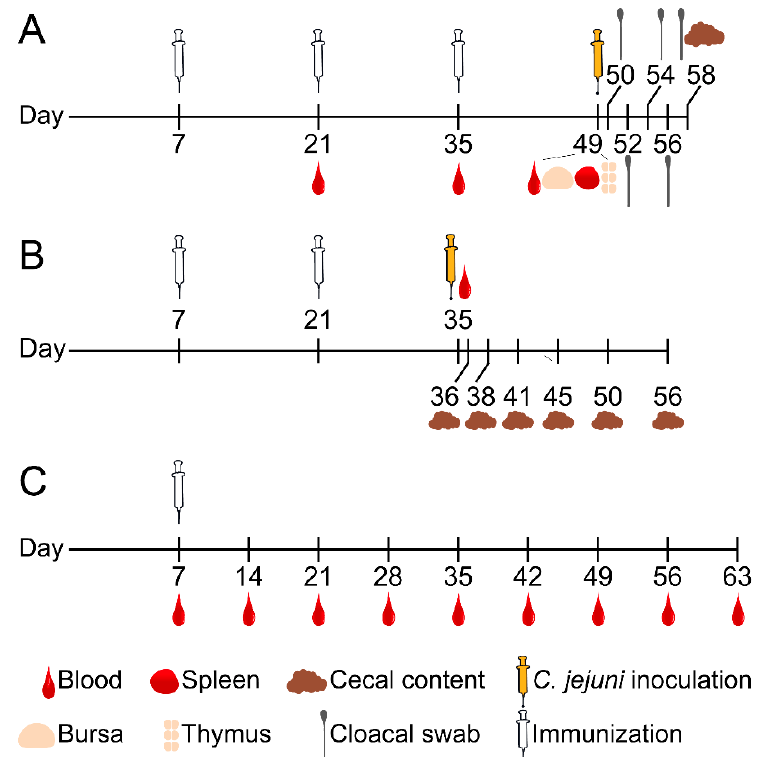
Figure 1. Diagram of three chicken immunization trials. For each trial (20–30 SPF chickens